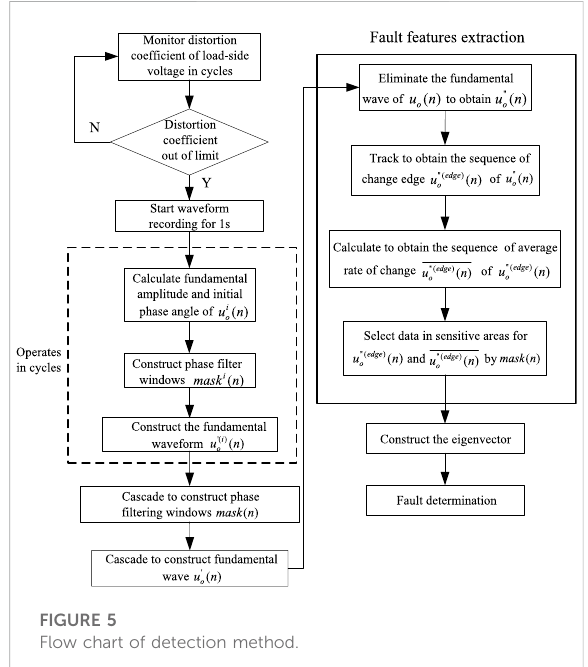
FIGURE 5 Flow chart of detection